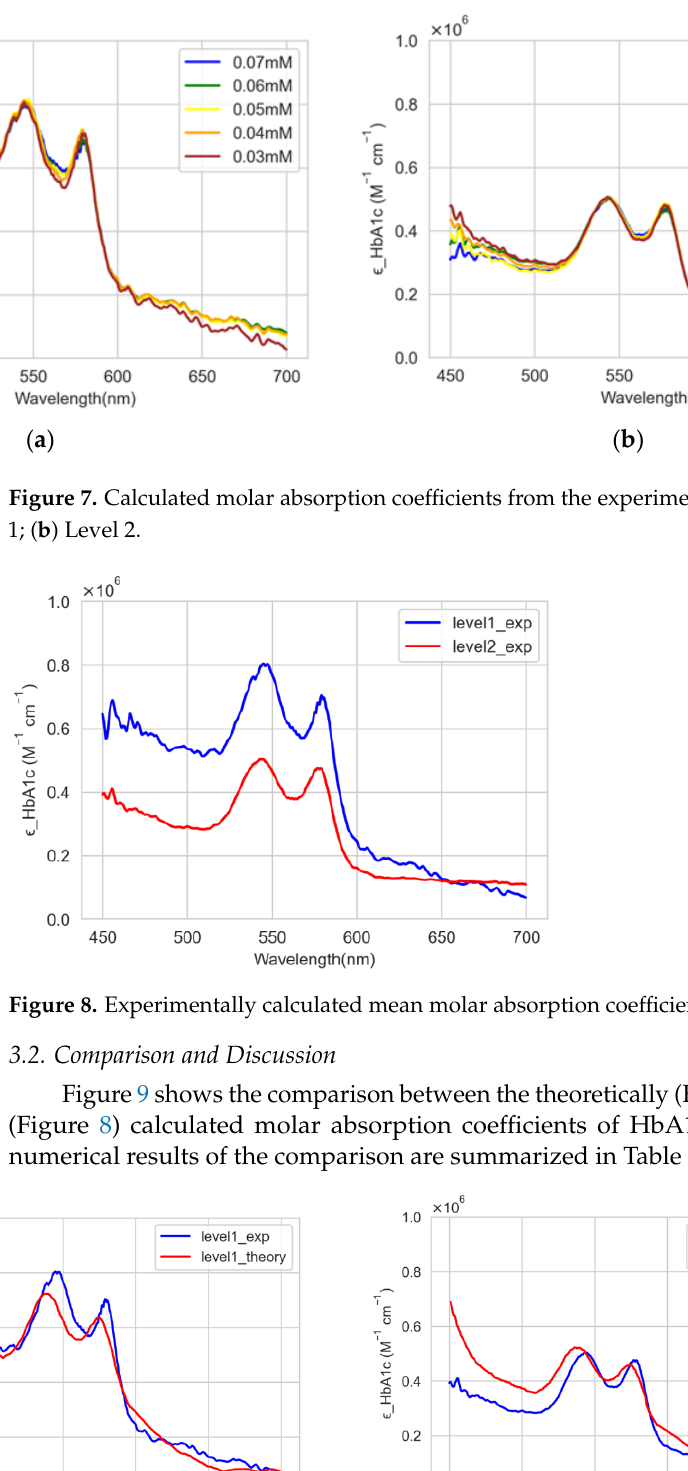
Figure 9. Comparison of the average molar absorption coefficients of HbA1c between the theoretically and experimentally calculated results from 450 nm to 700 nm. ( a ) Level 1; ( b ) Level 2. Table 1. Comparison of the molar absorption coefficients of HbA1c at two peak wavelengths for the theoretically and experimentally obtained results.